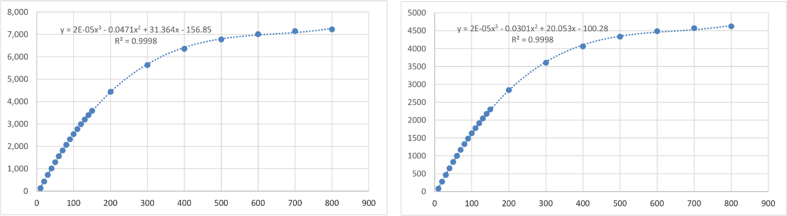
Health burden calculation. Exposure to air pollution on the x-axis and life years lost on the y-axis. Korogocho (left) and Viwandani (right).